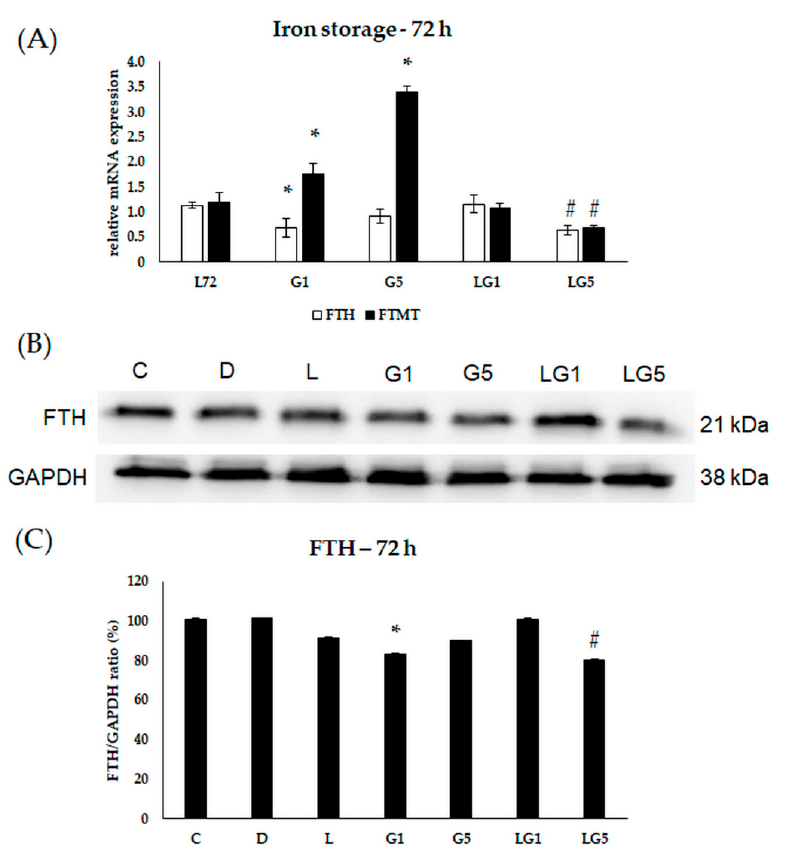
Figure 11. Determination of mRNA expression ( A ) and protein ( B , C ) levels of iron storing FTH and FTMT after lutein and Glu treatments of the SH-SY5Y cells at 72 h. SH-SY5Y cells were treated with 10 ng/µL of lutein, 1 mM, 5 mM Glu, or lutein with Glu together to detect the changes in the expression of FTH and FTMT. The gene expression measurements were performed by SYBR Green RT-PCR protocol with β -actin as a housekeeping gene, the relative expression of controls was regarded as 1. The protein expression measurements were performed by semi-dry Western blotting using GAPDH as a loading control. The protein’s OD was expressed as a percentage of the target protein/GAPDH ratio. The bars represent the mean values ( ± standard deviation error bars, SD) of three independent experiments ( n = 3) performed in triplicate and presented relative to their control cells. The * marks the statistical significance of Glu treatments compared to control, # shows the statistical significance of combined (lutein with Glu) treatments compared to the Glu treatments at 72 h ( p <